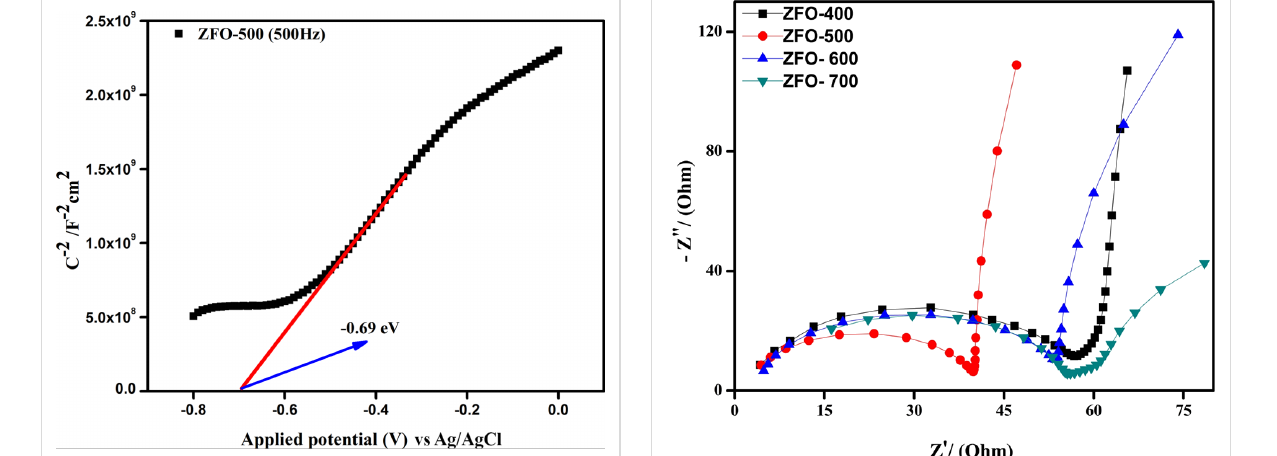
was calculated to be − 0.69 eV (vs Ag/AgCl) or − 0.09 eV (vs